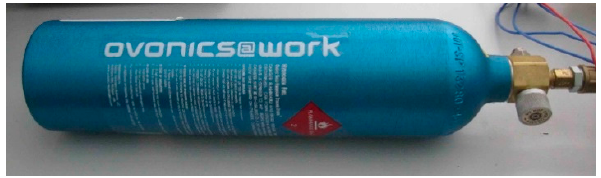
Figure 4. The Ovonic™ solid hydrogen storage canister, 760 sl (standard liters).